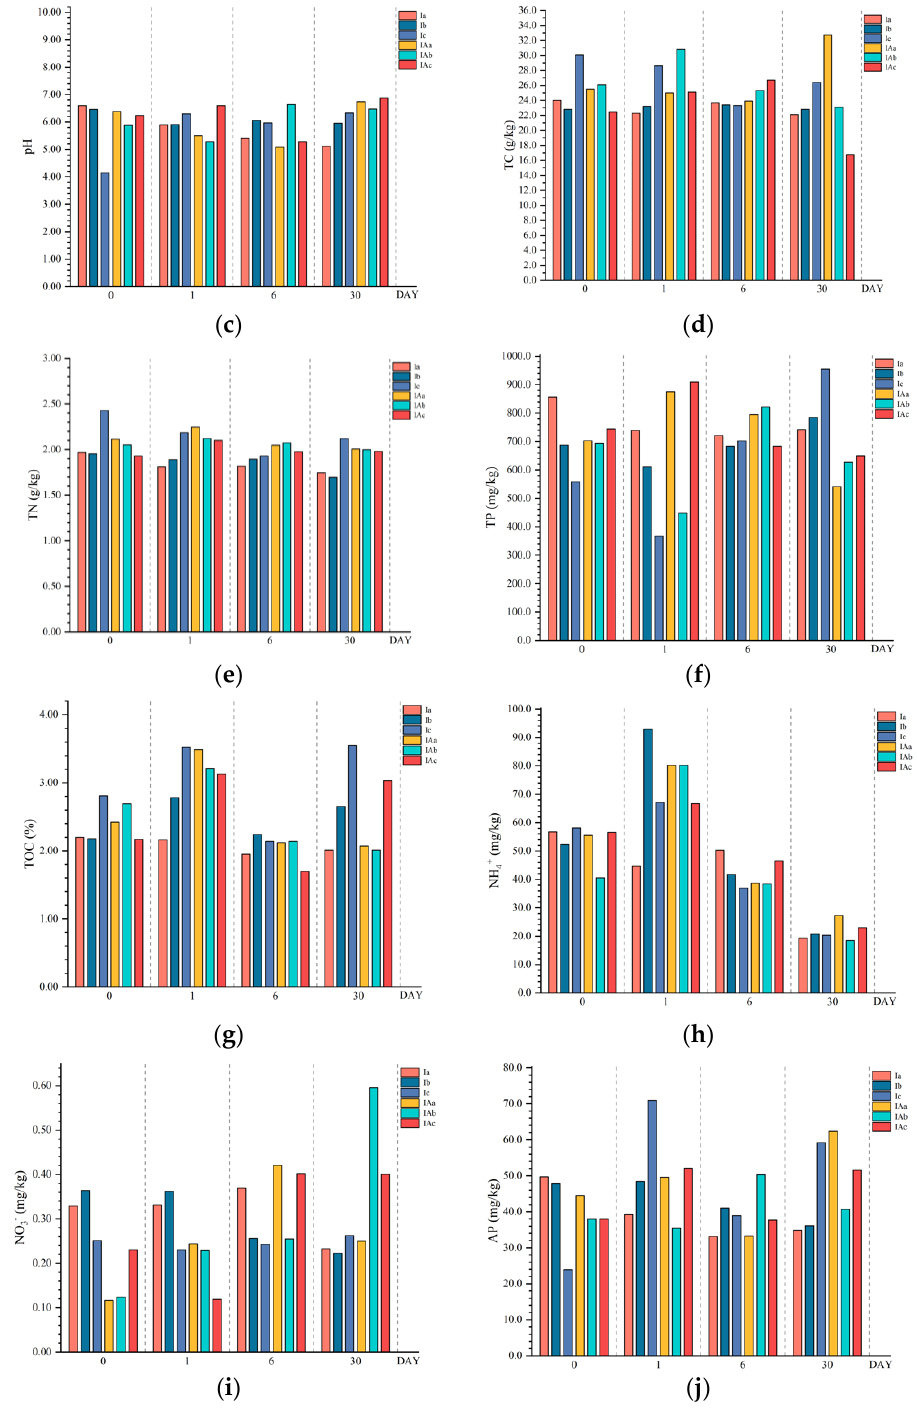
Figure 3. Changes in soil physicochemical properties at different plant growth stages: ( a ) soil VWC; ( b ) soil EC; ( c ) soil pH; ( d ) soil TC; ( e ) soil TN; ( f ) soil TP; ( g ) soil TOC; ( h ) soil NH 4+ -N; ( i ) soil NO 3 − -N; ( j ) soil AP.